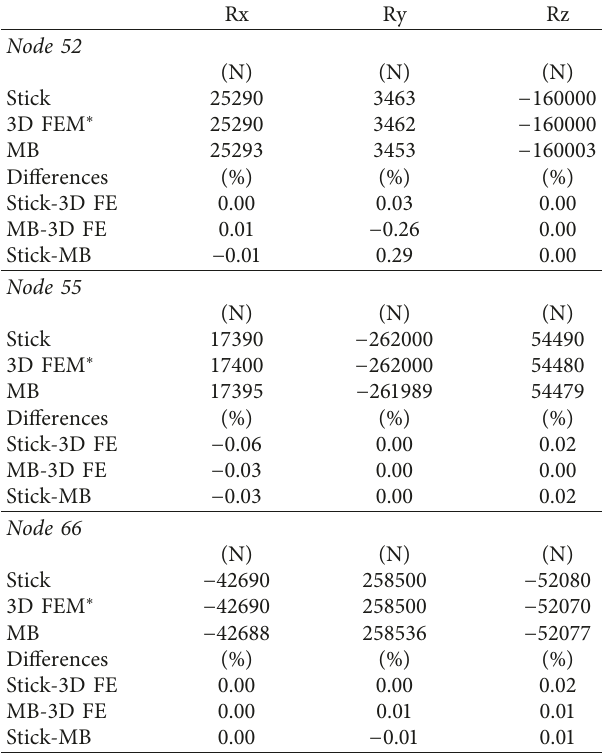
Table 3: Reaction forces achieved for the main landing gear by the stick, modified 3D FE